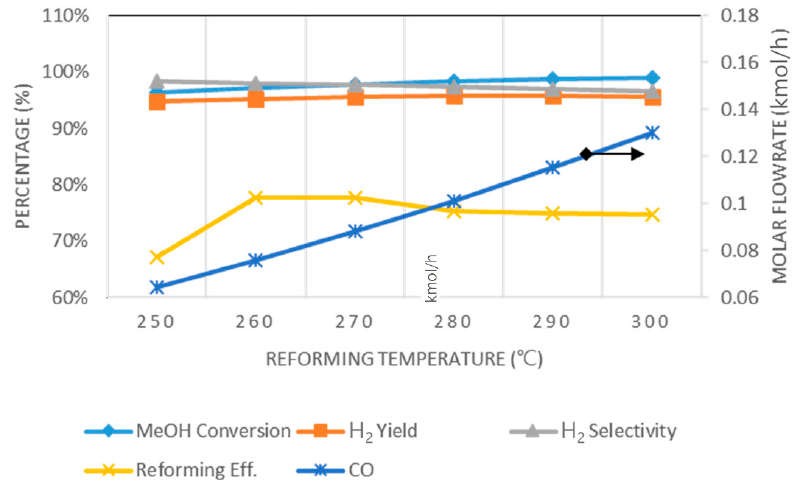
Figure 9. Effect of reforming temperature on MeOH conversion, H 2 yield, H 2 selectivity, reforming efficiency and CO flow rate.